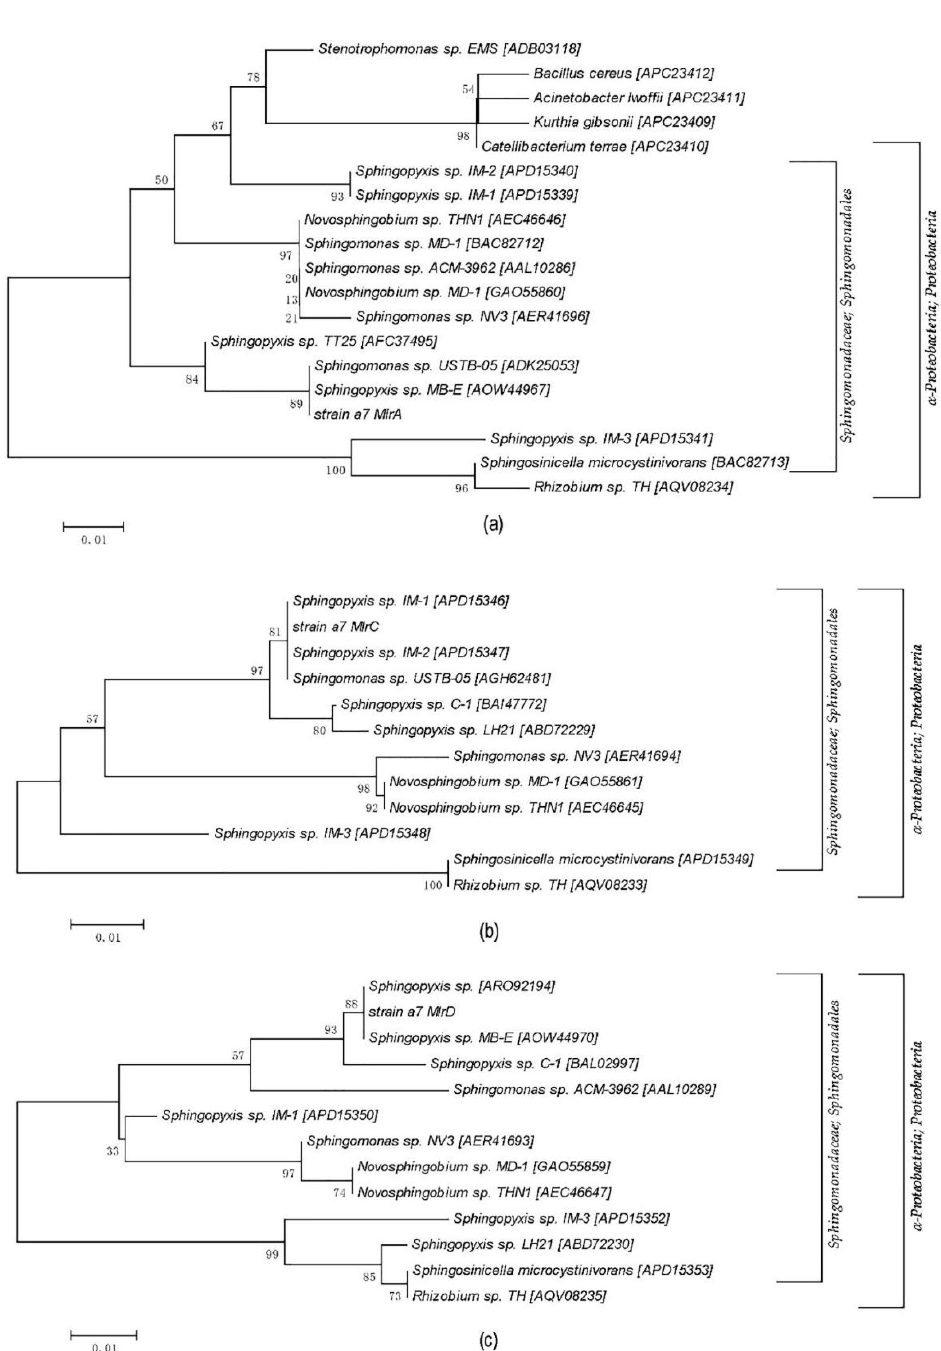
Figure 4. Amino acid sequences phylogenetic trees of mlrA, mlrC, and mlrD. The numbers at the nodes are the levels of bootstrap support (%) based on the neighbor-joining analyses of 1000 resampled datasets. The scale bar represents 0.01 estimated distance per position. ( a ) mlrA gene; ( b ) mlrC gene; ( c ) mlrD gene.